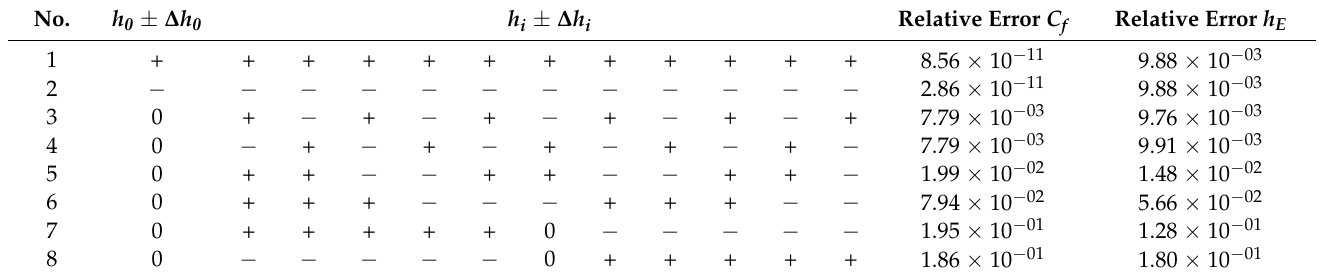
Table 5. Positive and negative error distributions of the sampling points ( N =